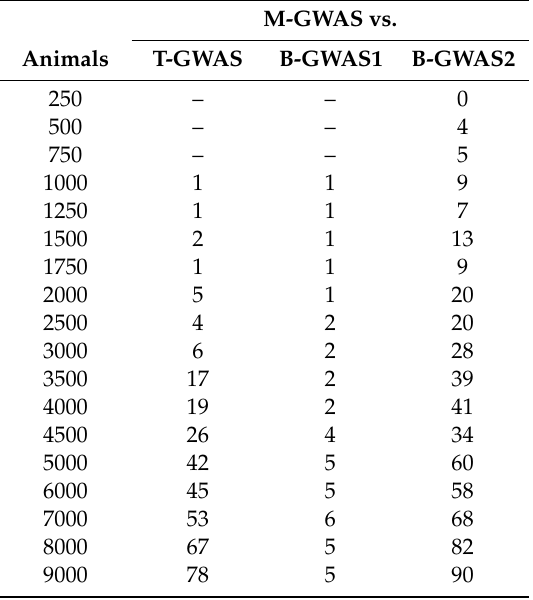
Table 3. Number of common QTLs detected by M-GWAS and T-GWAS, B-GWAS1 and B-GWAS2.